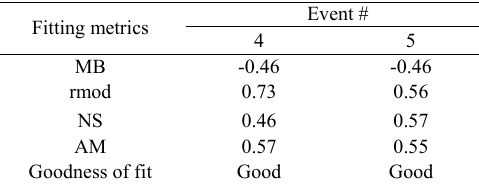
Table 6. Fitting metrics during validation analysis for direct runoff simulation